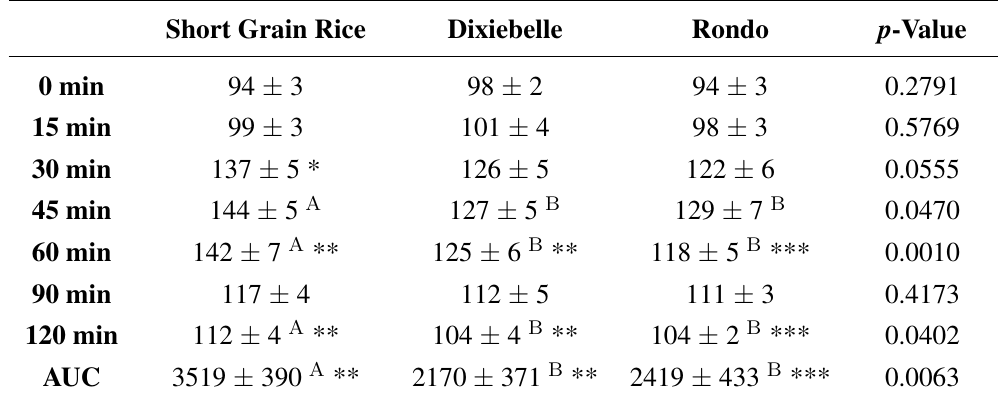
Table 3. Capillary blood glucose values (mg/dL, mean ± SEM) and AUC (mg*min/dL, mean ± SEM) before (0 min) and after treatment intake in healthy adults ( n = 18). Short Grain Rice